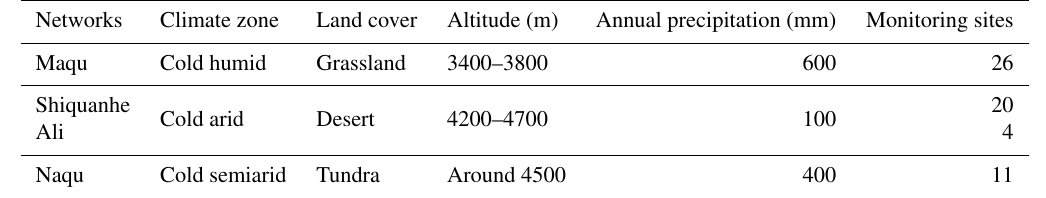
Table 2. Information on the Tibet-Obs